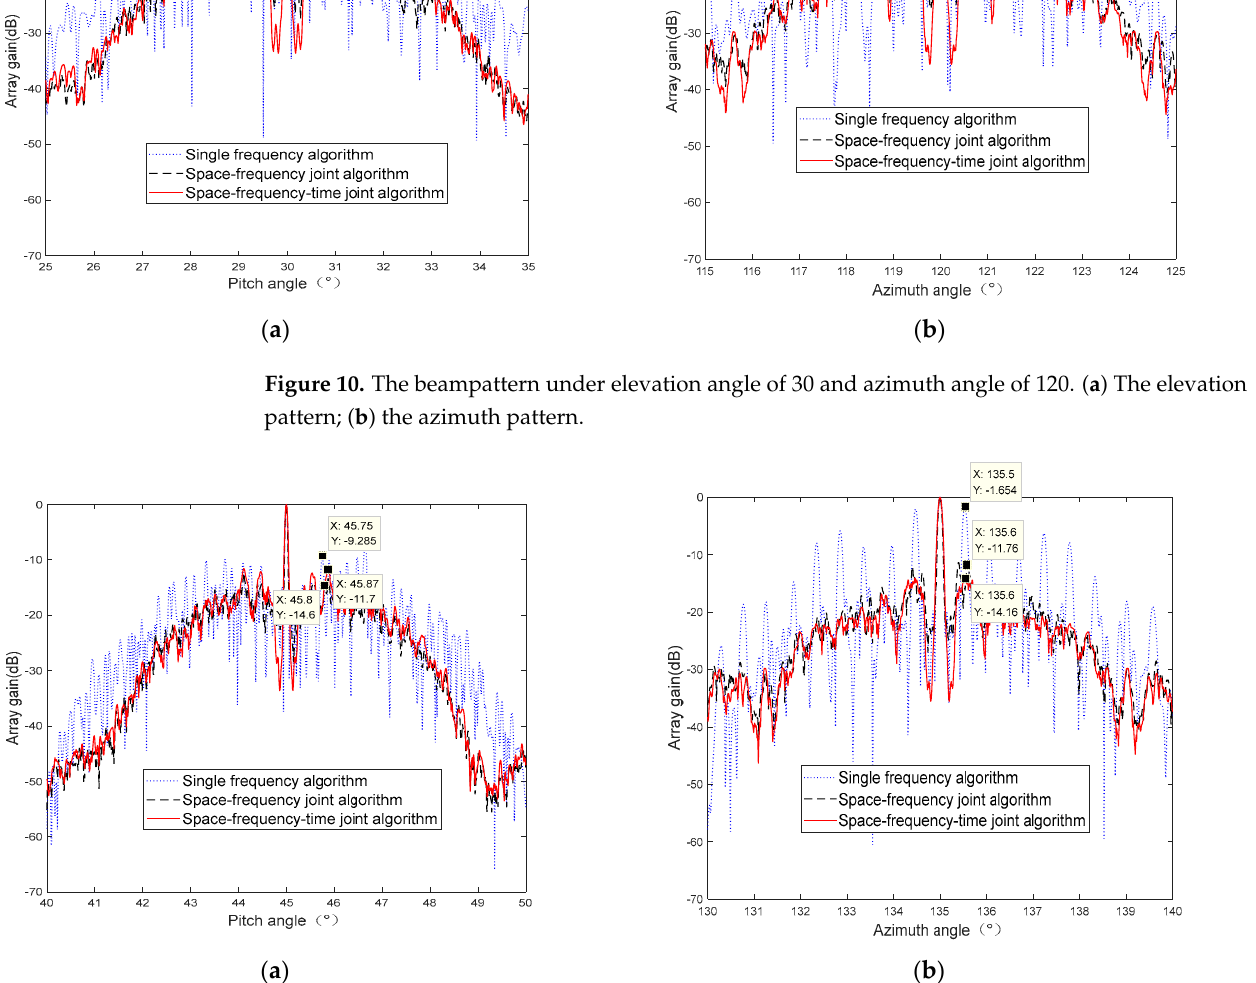
Figure 11. The beampattern under elevation angle of 45 and azimuth angle of 135. ( a ) The elevation pattern; ( b ) the azimuth pattern.